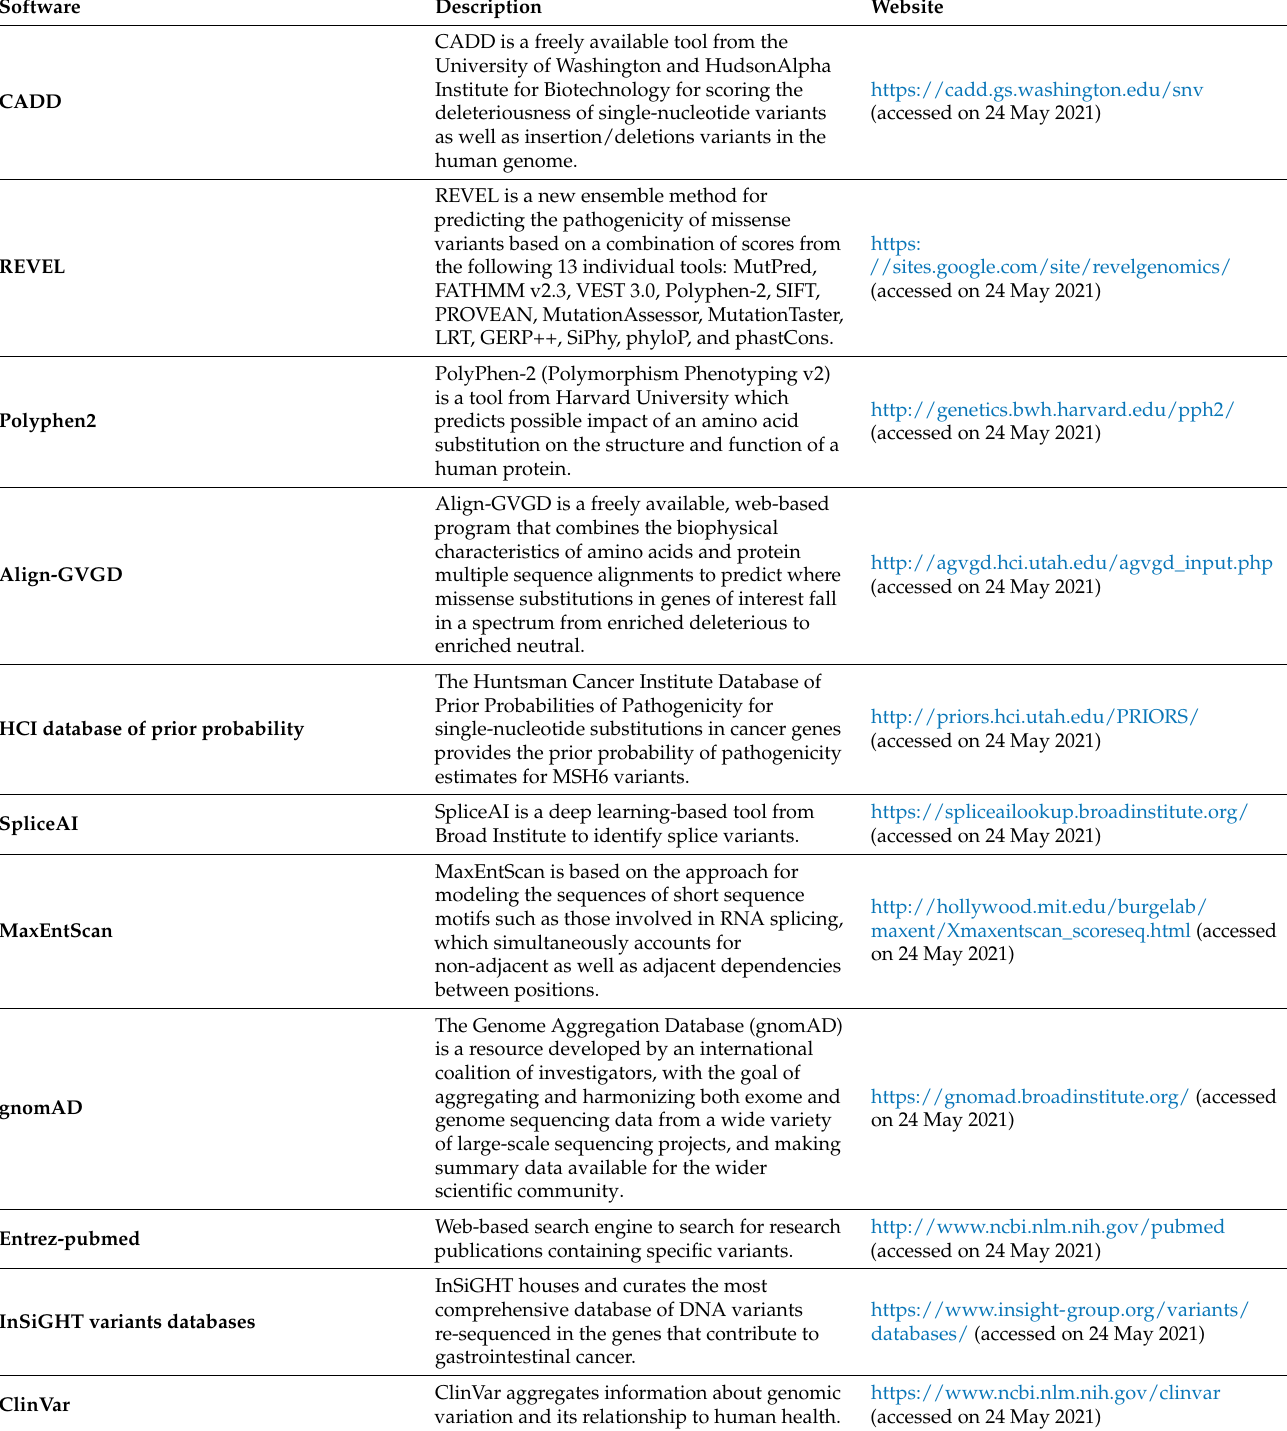
Table 1. Software and additional tools for evaluation of MSH6